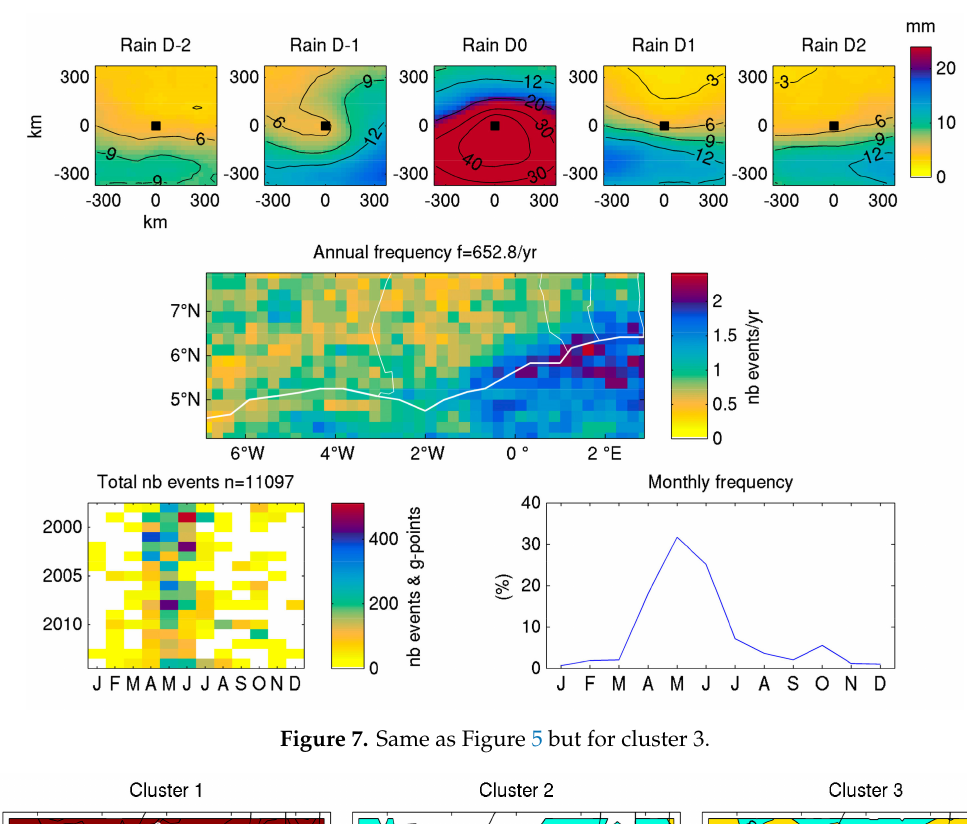
Figure 7. Same as Figure 5 but for cluster 3.